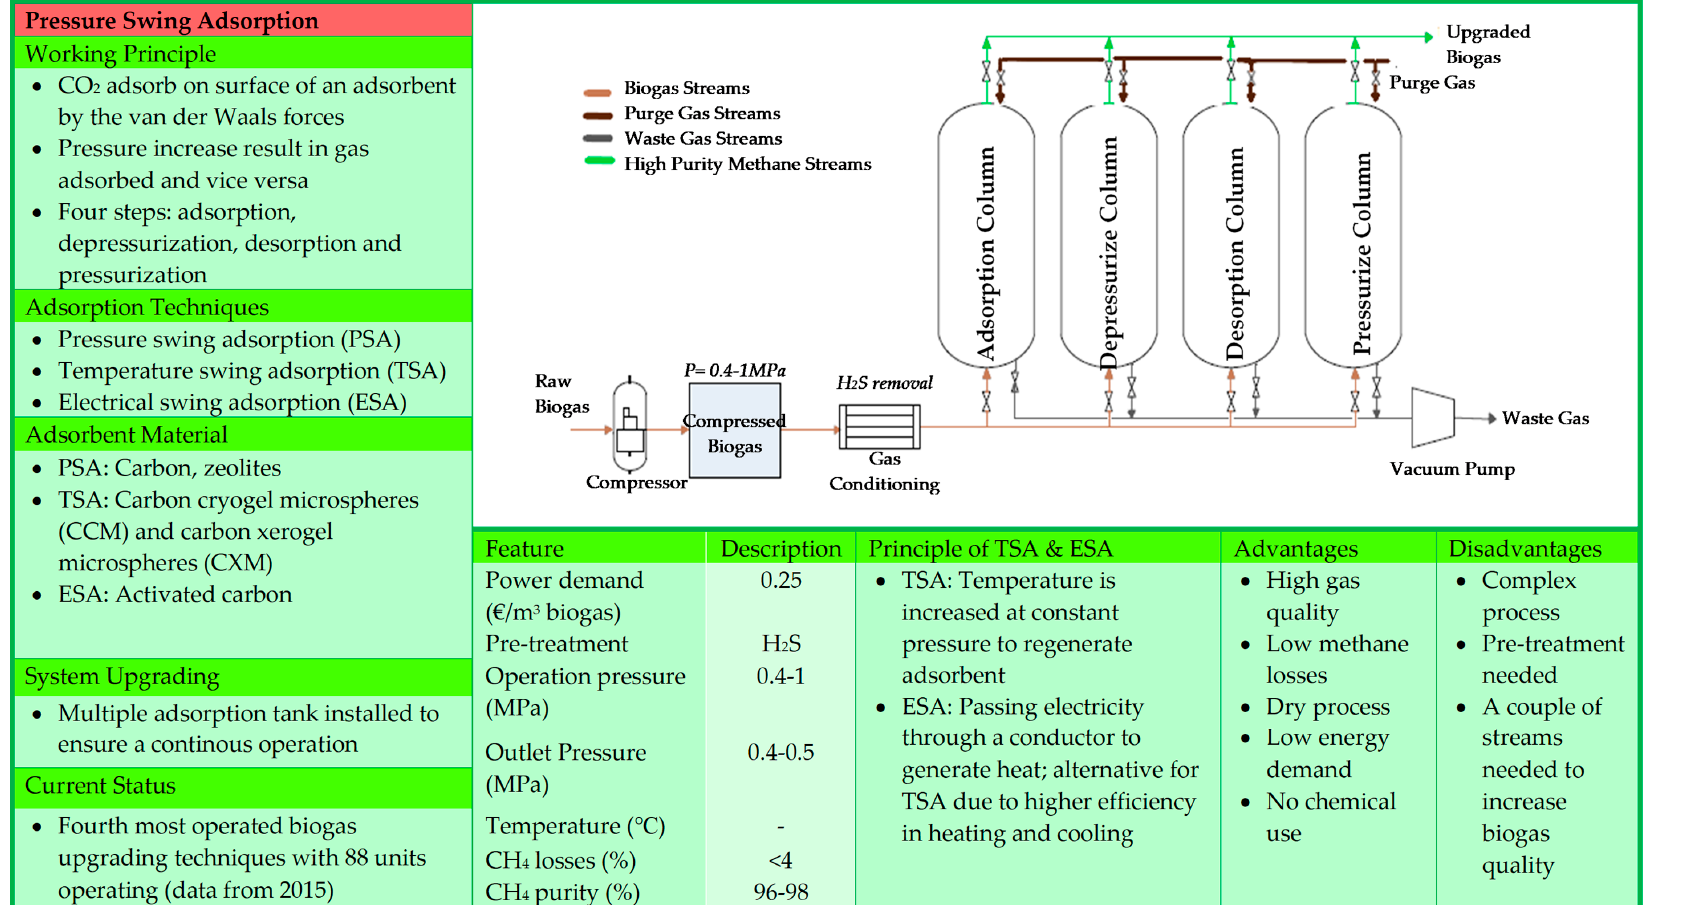
Figure 4. Depicts information on pressure swing adsorption technology [19,20,25,28,33–37].